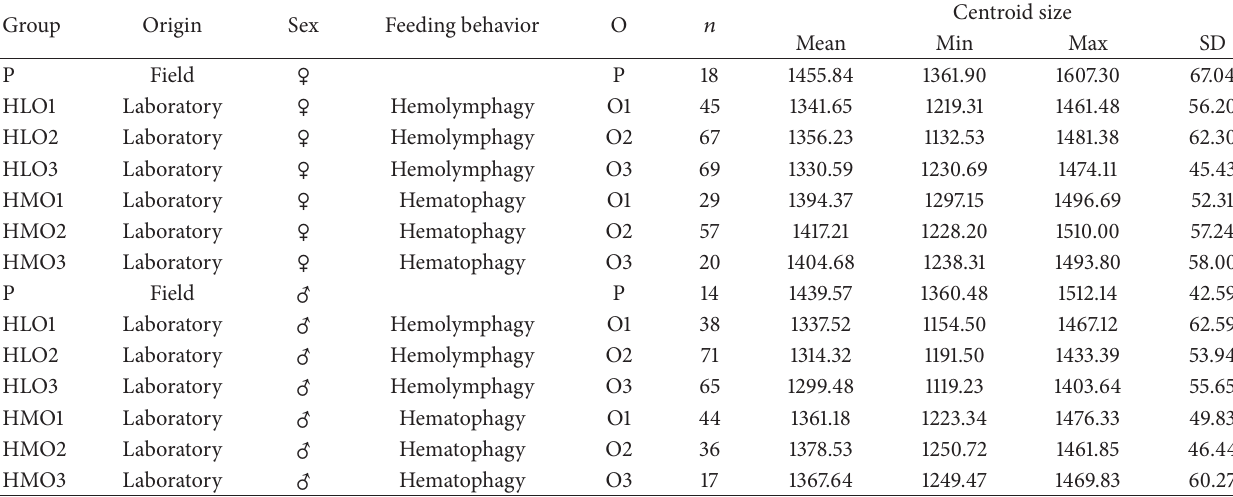
Table 1: The numbers of specimens ( 𝑛 ), mean, and standard deviation of centroid size for each group classified by host and sex.